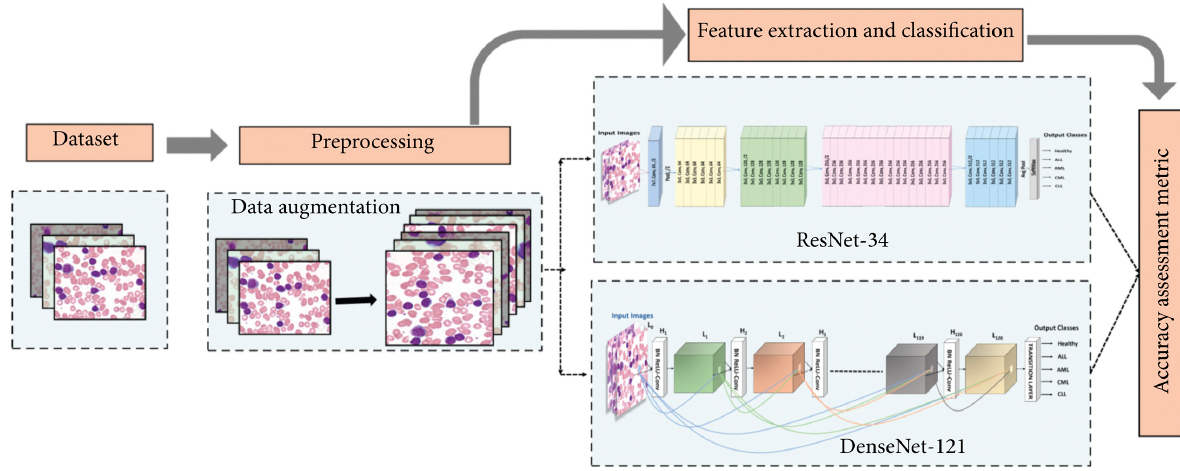
Figure 2. Proposed methodology for detecting and subtyping leukemia (Bibi et al., 2020) [26] .